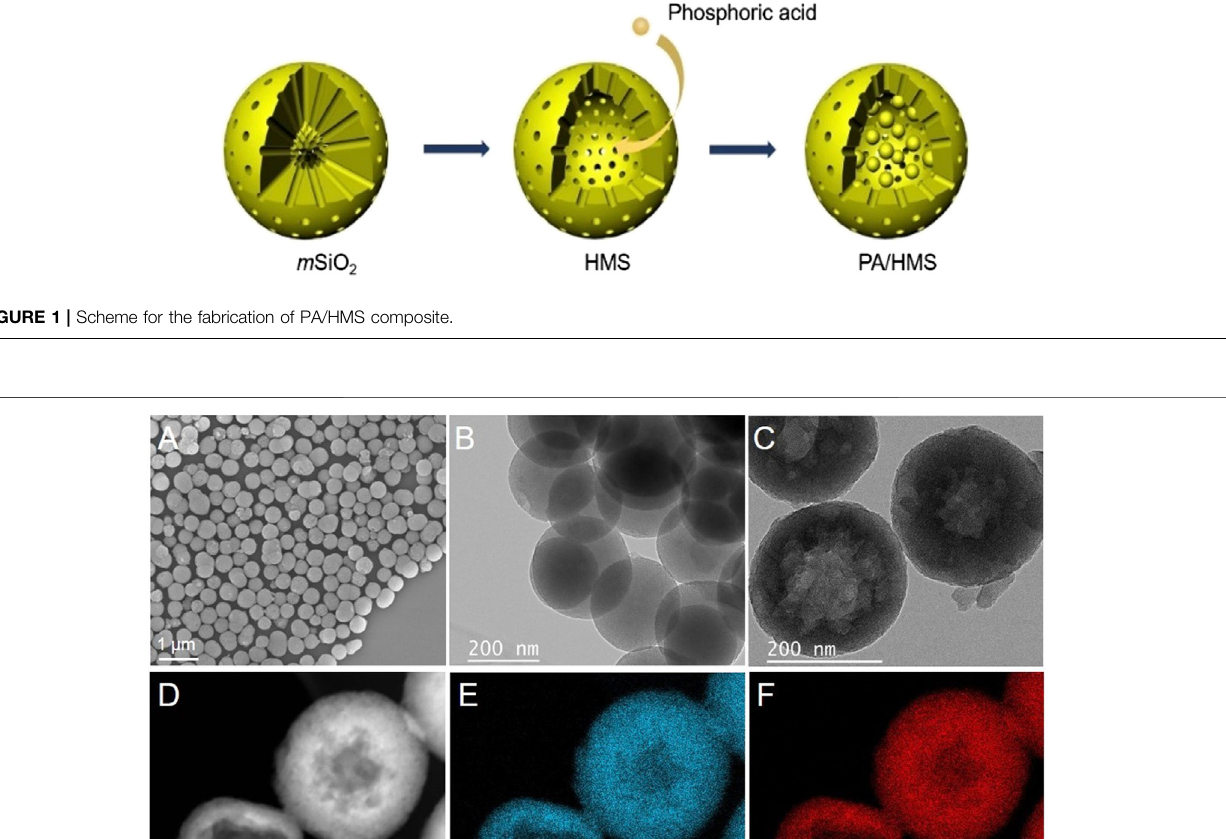
Frontiers in Energy Research |